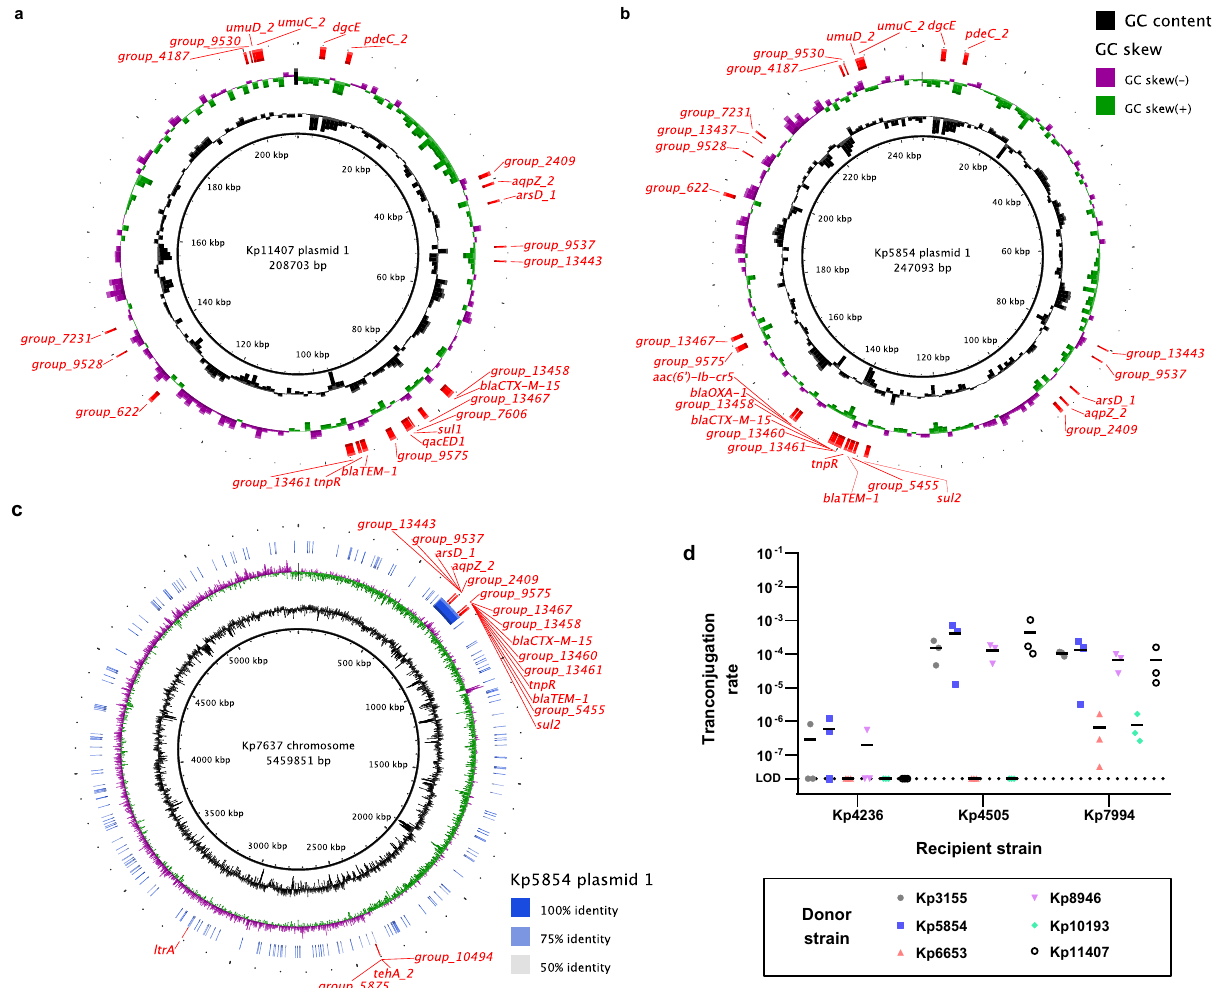
Fig. 4 | Infection-associated genes are present on large, conjugative plasmids. a Plasmid map of Kp11407 plasmid 1. b Plasmid map of Kp5854 plasmid 1. c Alignment of Kp7637 chromosome and Kp5854 plasmid 1. d Transconjugation rates using Kp3155, Kp5854, Kp6653, Kp8946, Kp10193, and Kp11407 as donor